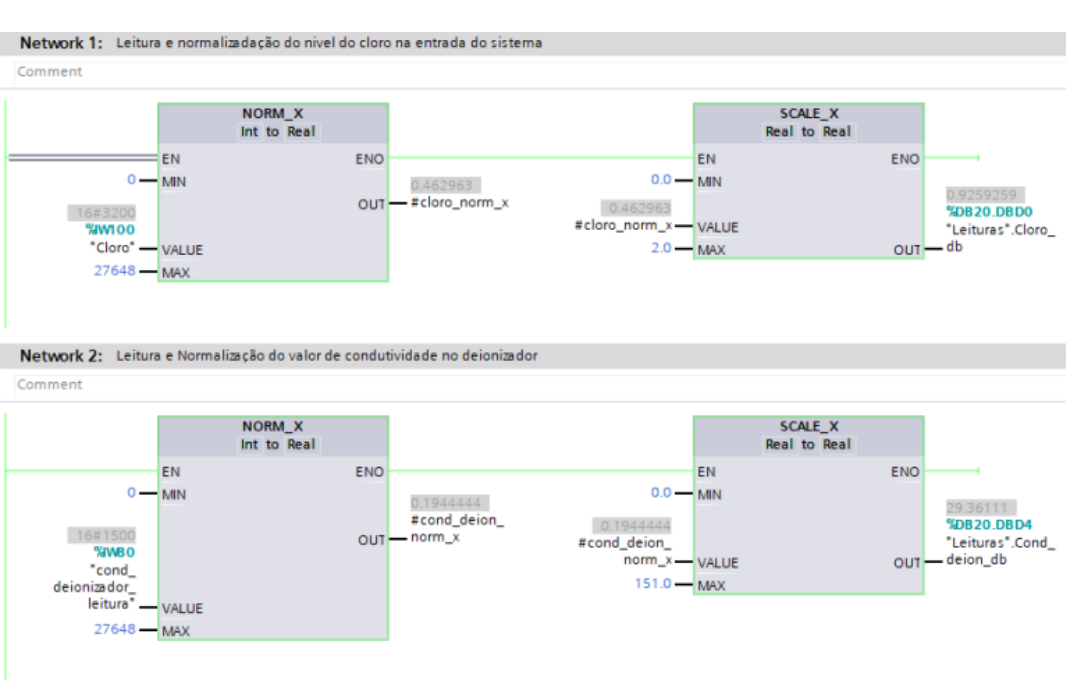
Figure 8. Configuration of the TIA Portal software to include the block diagram for normalization of the reading values of the